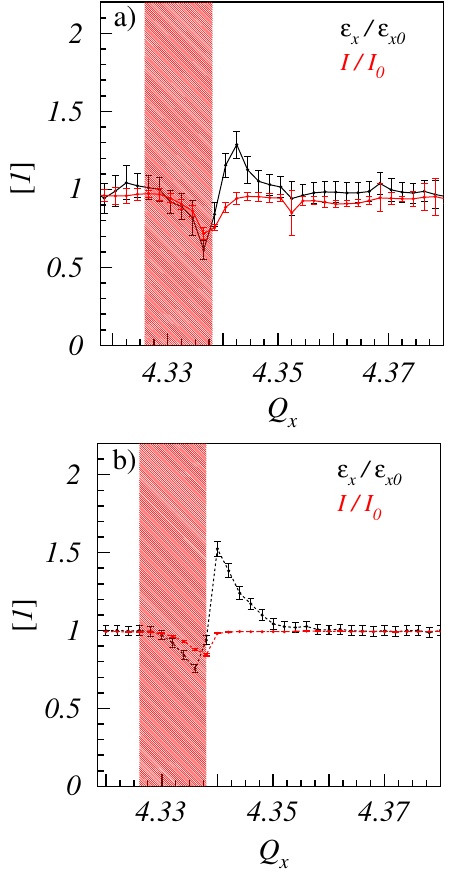
FIG. 8. High intensity coasting beam: (a) Normalized emit- tance increase and beam loss versus Q x . (b) Simulation of beam loss and emittance increase versus Q x . For this simulation the beam intensity has been taken so as to create a maximum tune shift of (cid:1) Q x ’ (cid:1) 0 : 025